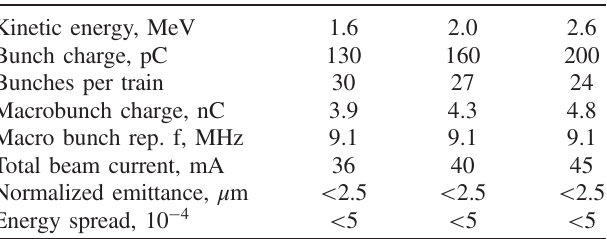
TABLE I. Electron beam baseline parameters. Kinetic energy, MeV